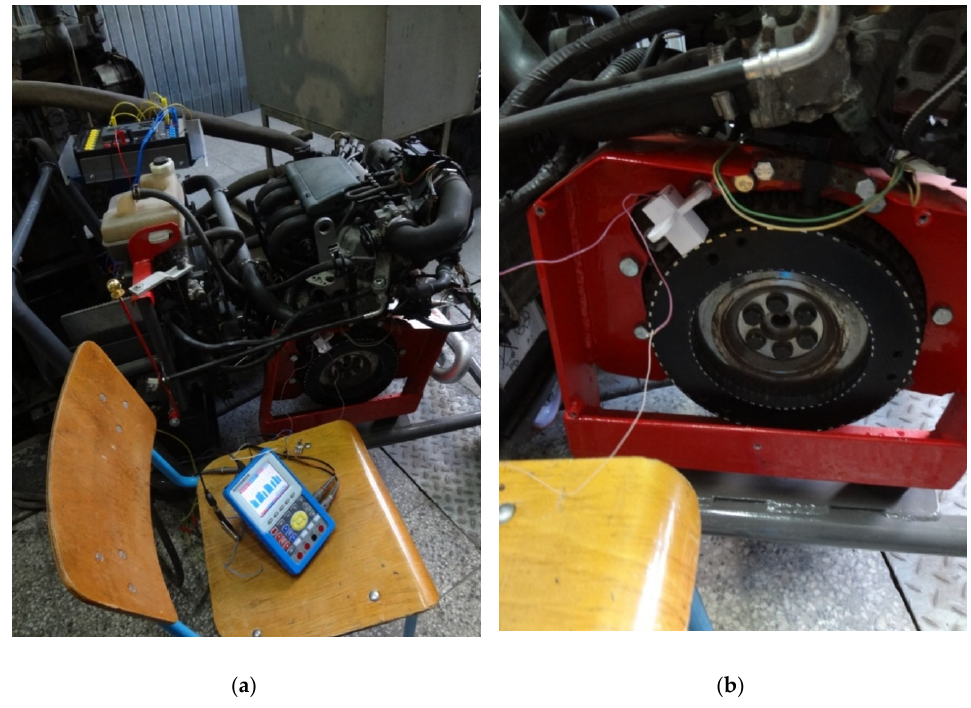
Figure 6. The measurement stand. ( a ) general view of the stand; ( b ) ME CKP and the crankshaft